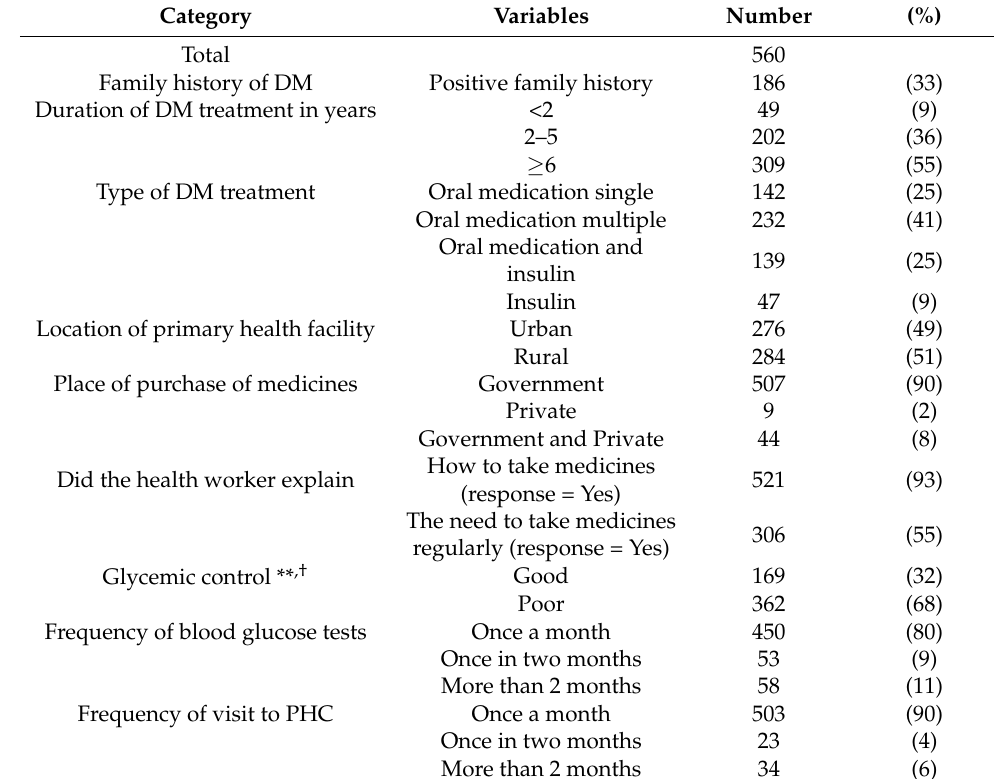
Table 2. Characteristics and management of DM in persons attending primary health care facilities, Kerala, India, 2021.